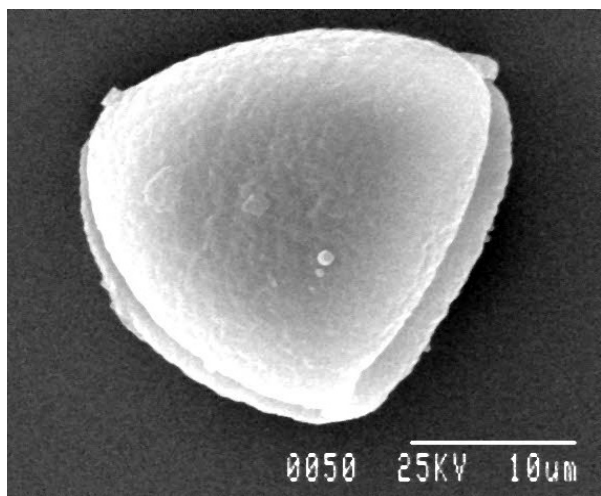
Fig. 19. X3000, showing exine pattern of Nymphaea stellata F.